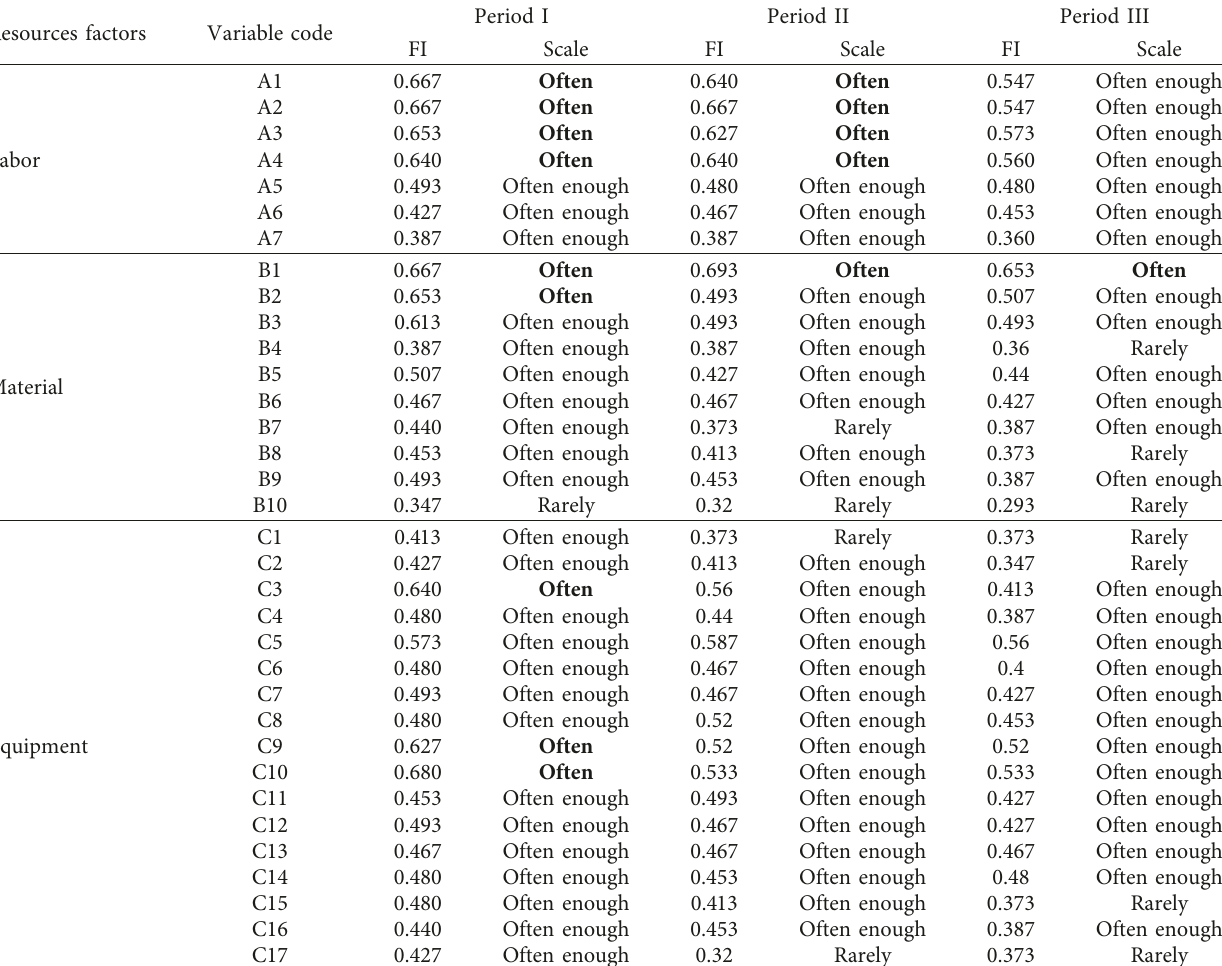
Table 10: Result of frequency index